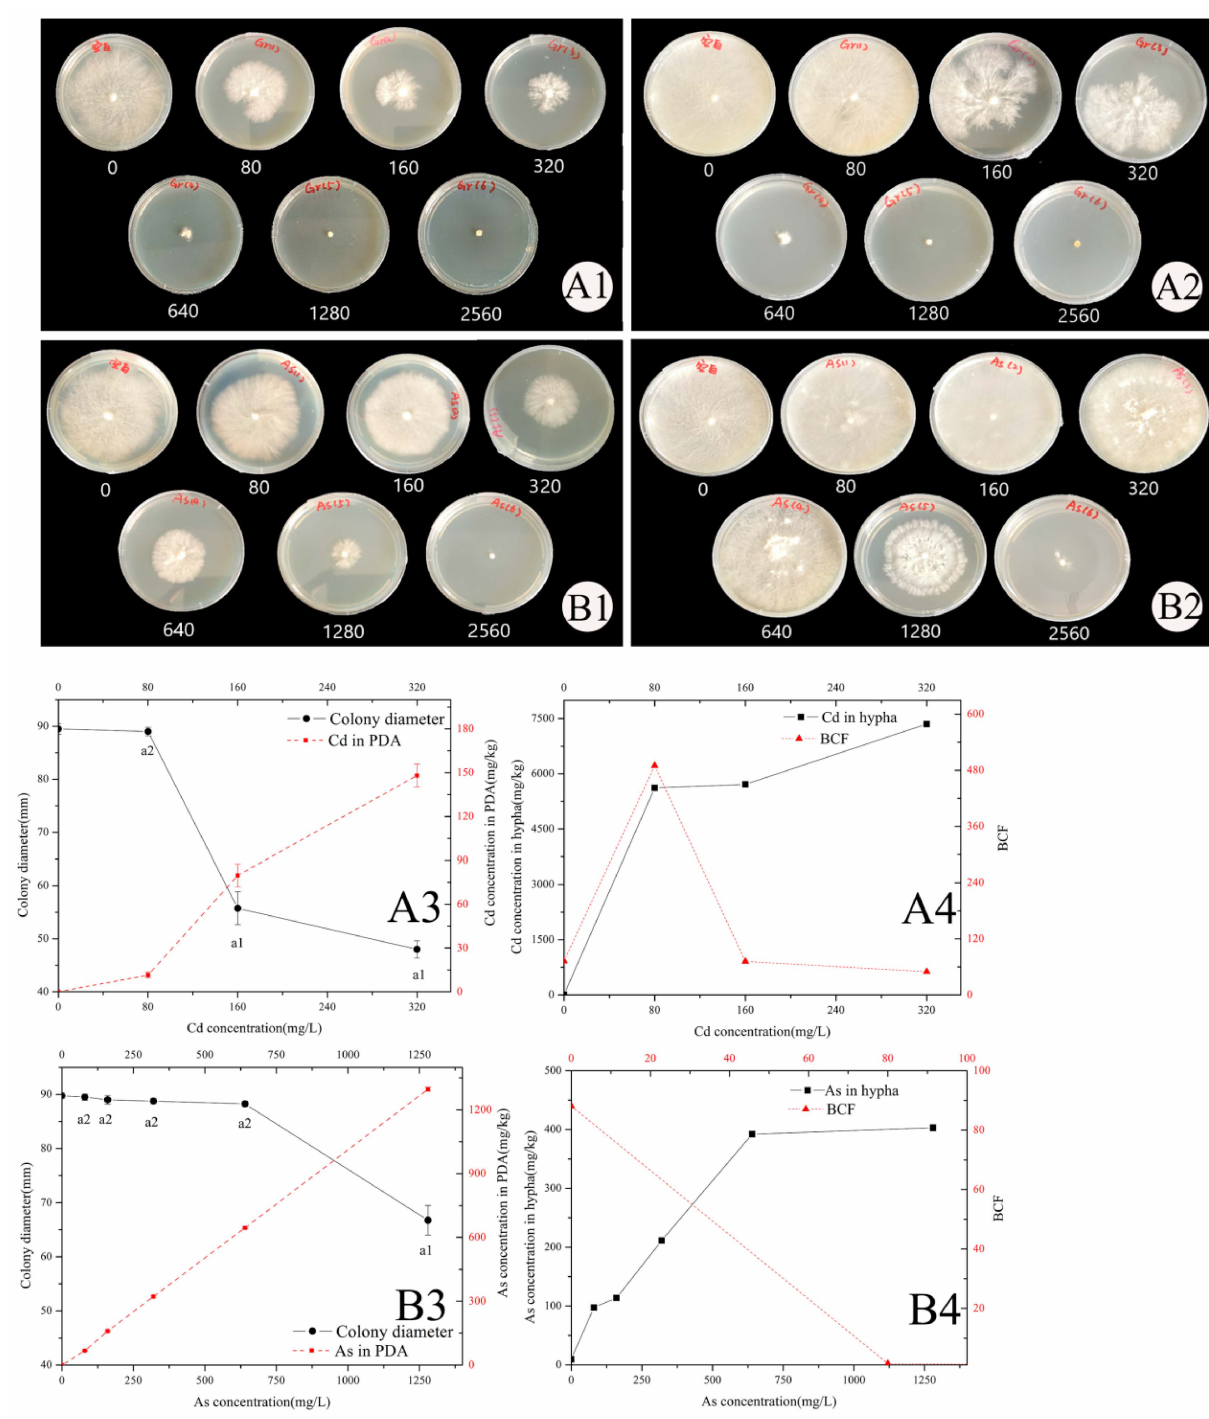
Figure 1. Effect of Cd and As stress on colony diameter and Cd/As content of the hypha in P. pulmonarius MT (X ± s, n = 4). ( A1 ) hypha incubated 7 d under Cd stress; ( A2 ) hypha in- cubated 14 d under Cd stress; ( B1 ) hypha incubated 7 d under As stress; ( B2 ) hypha incubated 14 d under As stress; ( A3 ) colony diameter and Cd content in PDA; ( A4 ) Cd content in hypha and bio-enrichment coefficients (BCF); ( B3 ) colony diameter and As content in PDA; ( B4 ) As content in hypha and bio-enrichment coefficients (BCF); a1: Each group was compared to CK group and two groups were significantly different ( p < 0.05); a2: Each group was compared to CK group and two groups were not significantly different ( p >